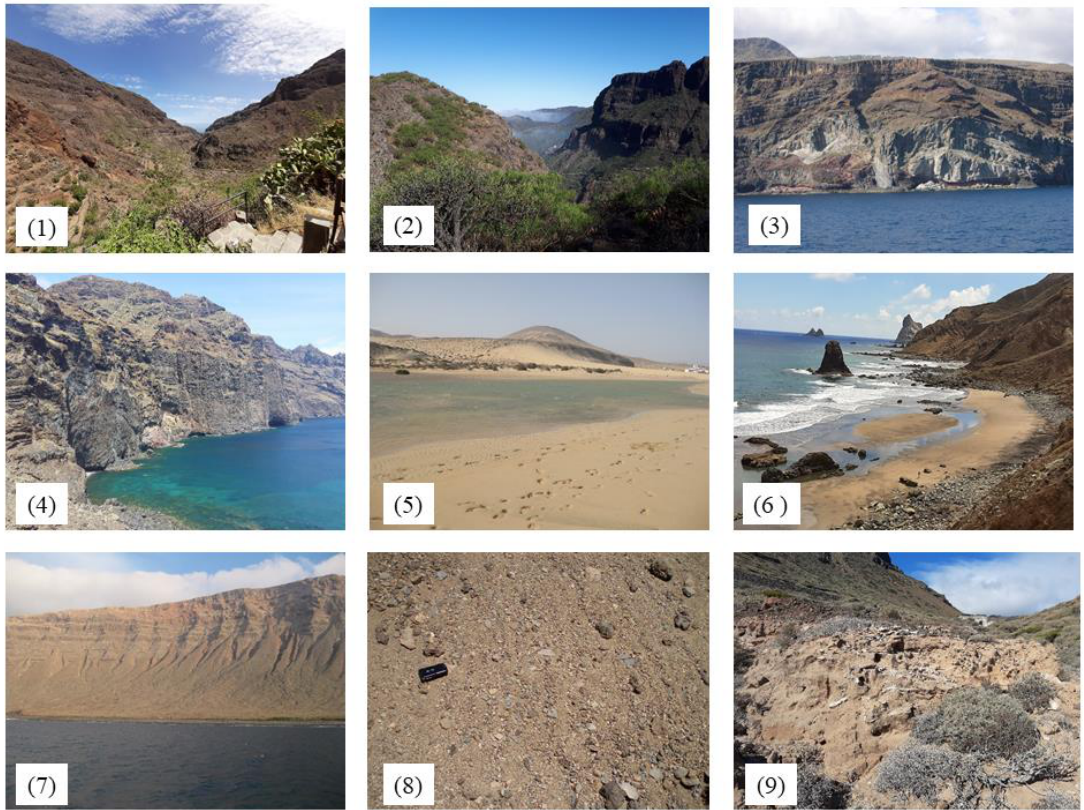
Figure 7. Forms associate to the erosion and accumulation processes. Ravines of Guayadeque in Gran Canaria ( 1 ) and Masca in Tenerife ( 2 ). Cliffs in La Gomera ( 3 ) and Tenerife ( 4 ). Beaches in Fuerteventura ( 5 ) and Benijos in Tenerife ( 6 ). Deposits associate to slope dynamic in Famara in Lanzarote ( 7 ). Deposits associate to periglacial processes in Teide National Park in Tenerife ( 8 ) and fossil dune in Puntalla in La Gomera ( 9 ).